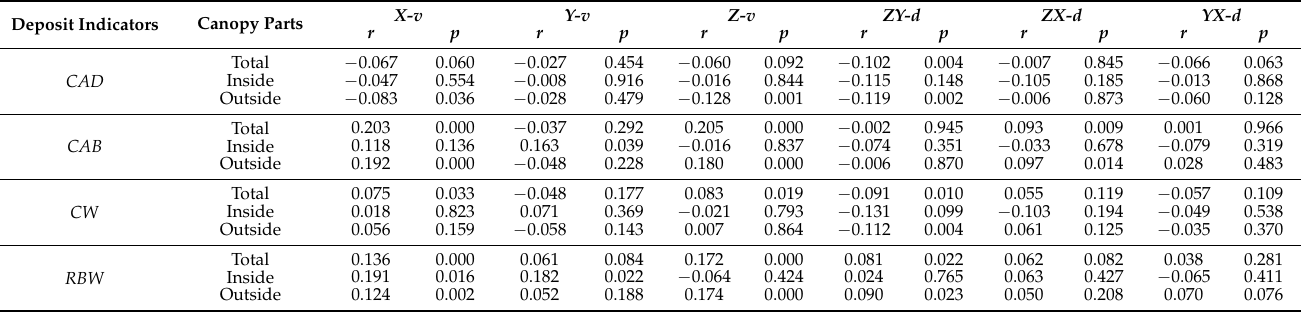
Table 5. Results of the correlation analysis between airflow and deposit indicators at different parts of pear canopy.